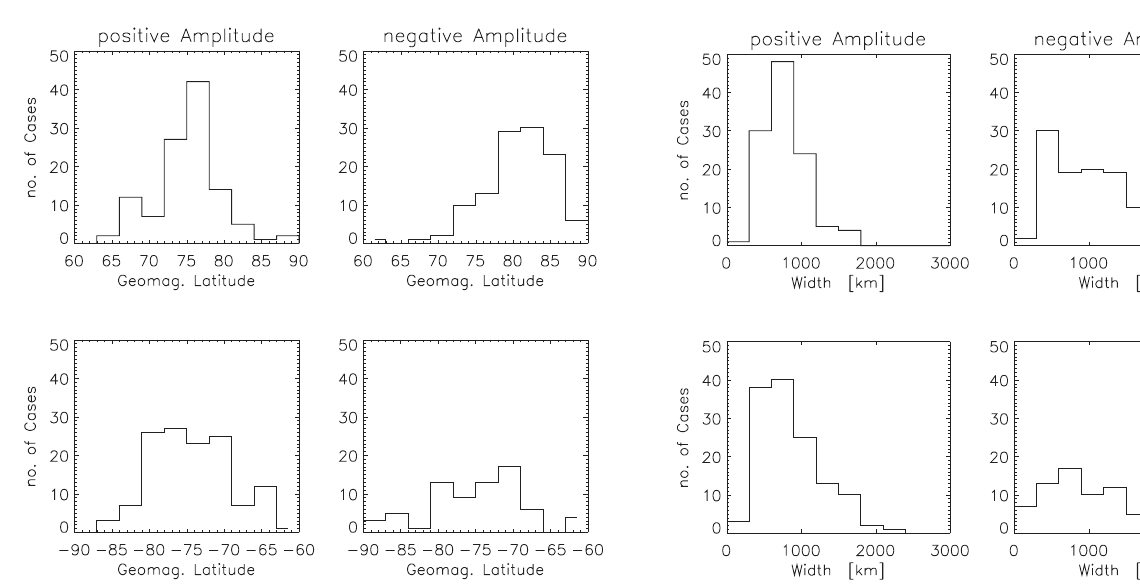
Fig. 5. Same as Fig. 4 but as a function of the width of the max-